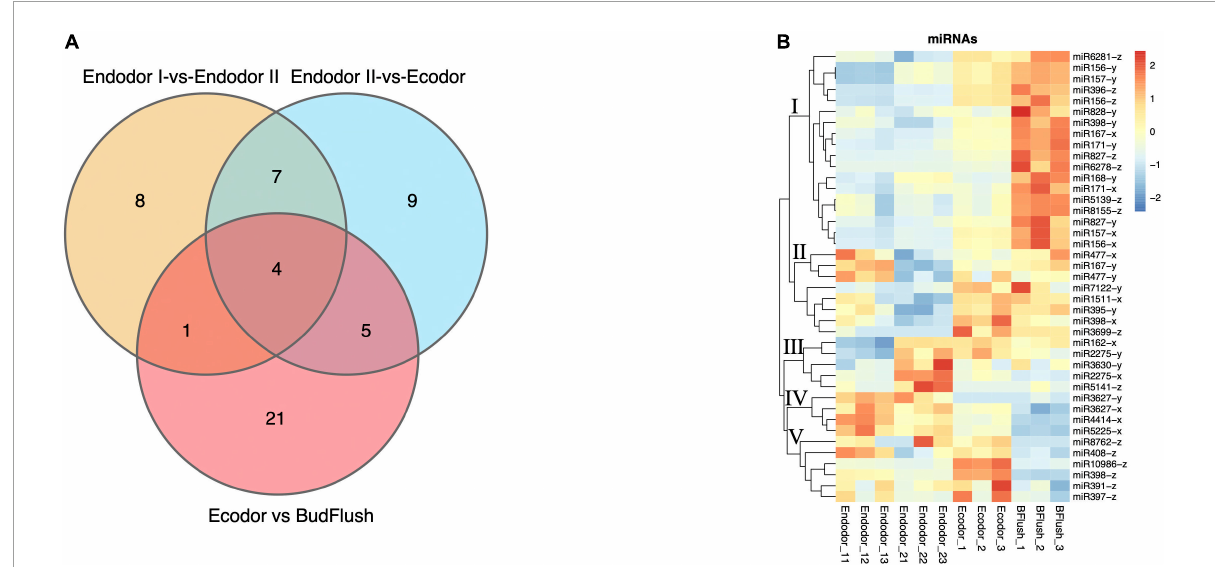
FIGURE5 The differential expression analysis identified known miRNAs differentially expressed across stage comparisons. (A) Venn diagram of known DEmiRNAs identified across four stage comparisons. (B) Expression heatmap of known miRNAs displaying their expression pattern across four developmental